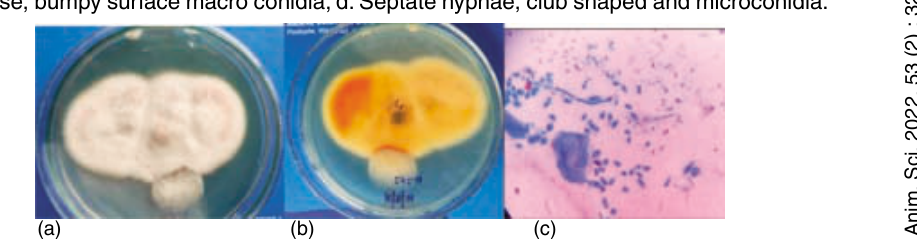
Fig. 5 . Microsporum nanum a . Powdery and soft fibrous colony; b. Yellowish-brown towards margin (reverse); c. Macroconidia;